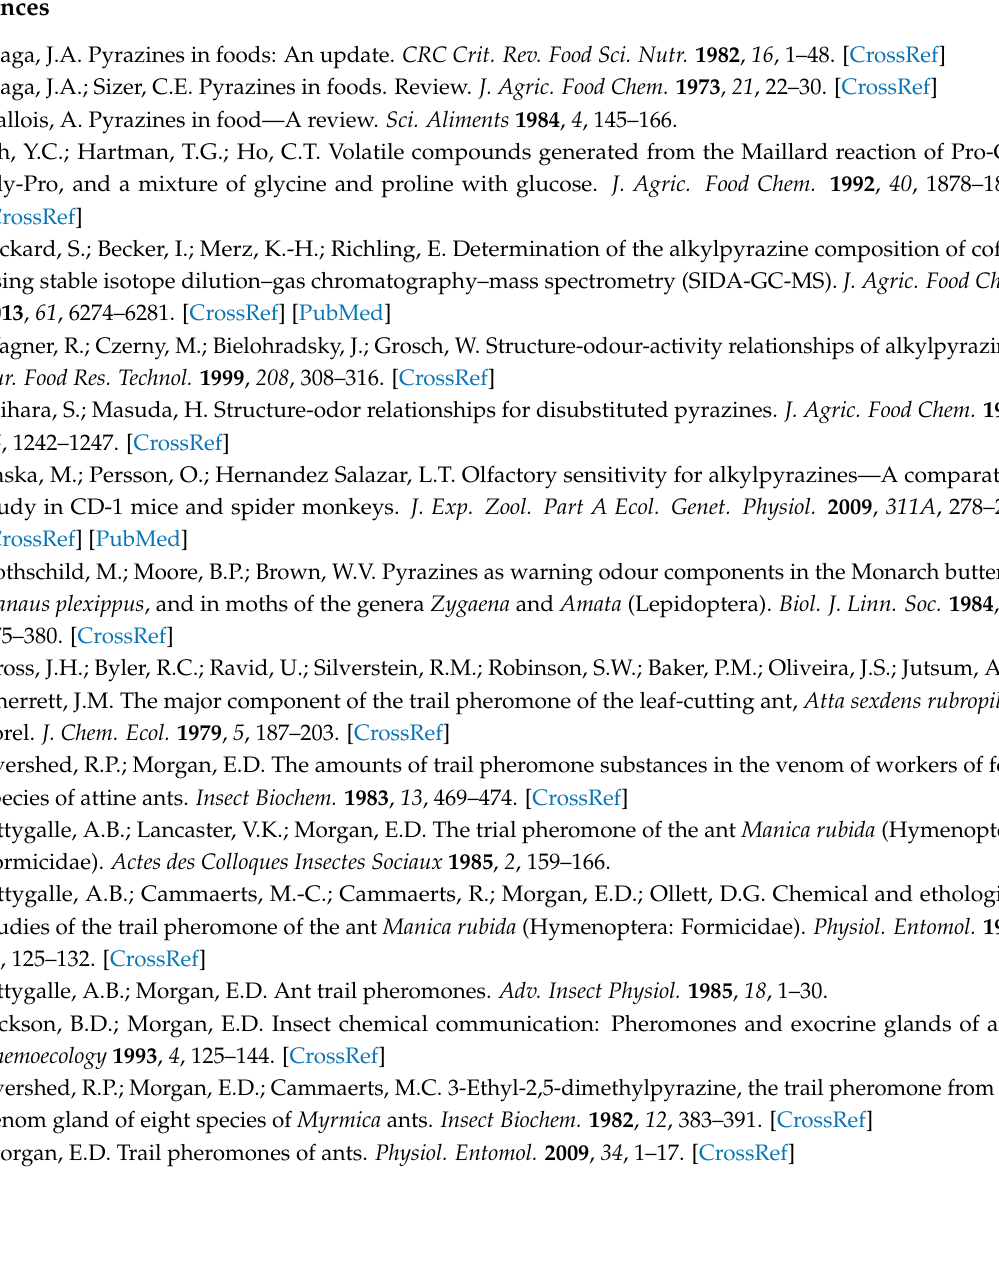
Supplementary Materials: The supplementary materials are available online. Figure S1. HPLC chromatogram of 2-methyl-3(5 or 6)-ethoxypyrazine. Mobile phase: Hexane-isopropanol 99.5:0.5. Figure S2. HPLC chromatograms of HPLC-purified EMPa (middle panel) and EMPb (bottom panel) in comparison with the mixture (top panel). Figure S3. HPLC chromatograms of HPLC-purified EMPc (middle panel) and EMPd (bottom panel) in comparison with the mixture (top panel). Figure S4. HSQC-and HMBC-2D NMR spectra of EMPa, 2E6MP. A: HSQC; B: HMBC. Figure S5. HSQC-and HMBC-2D NMR spectra of EMPb, 2E5MP. A: HSQC; B: